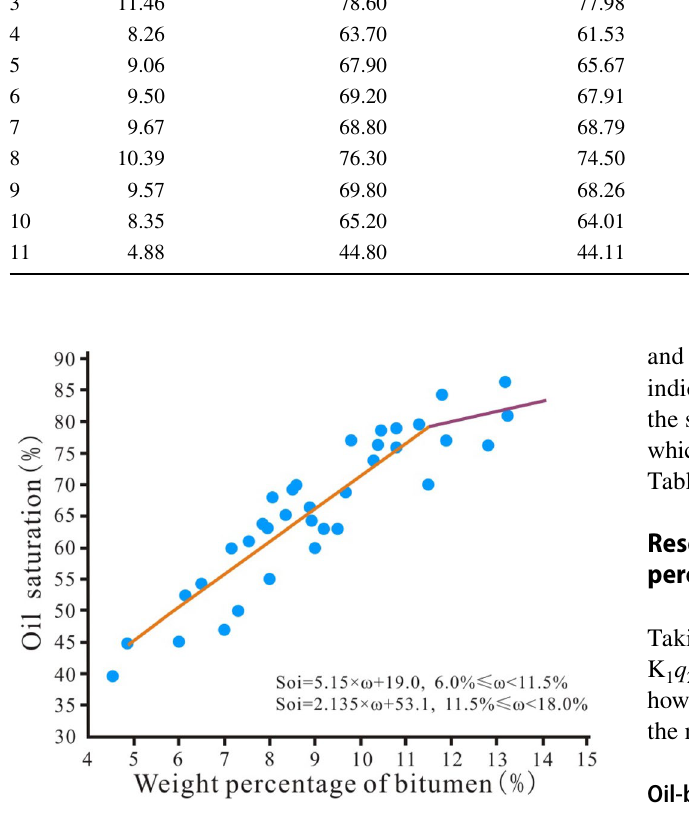
Fig. 6 Relation curve of oil saturation and weight percentage of bitu-